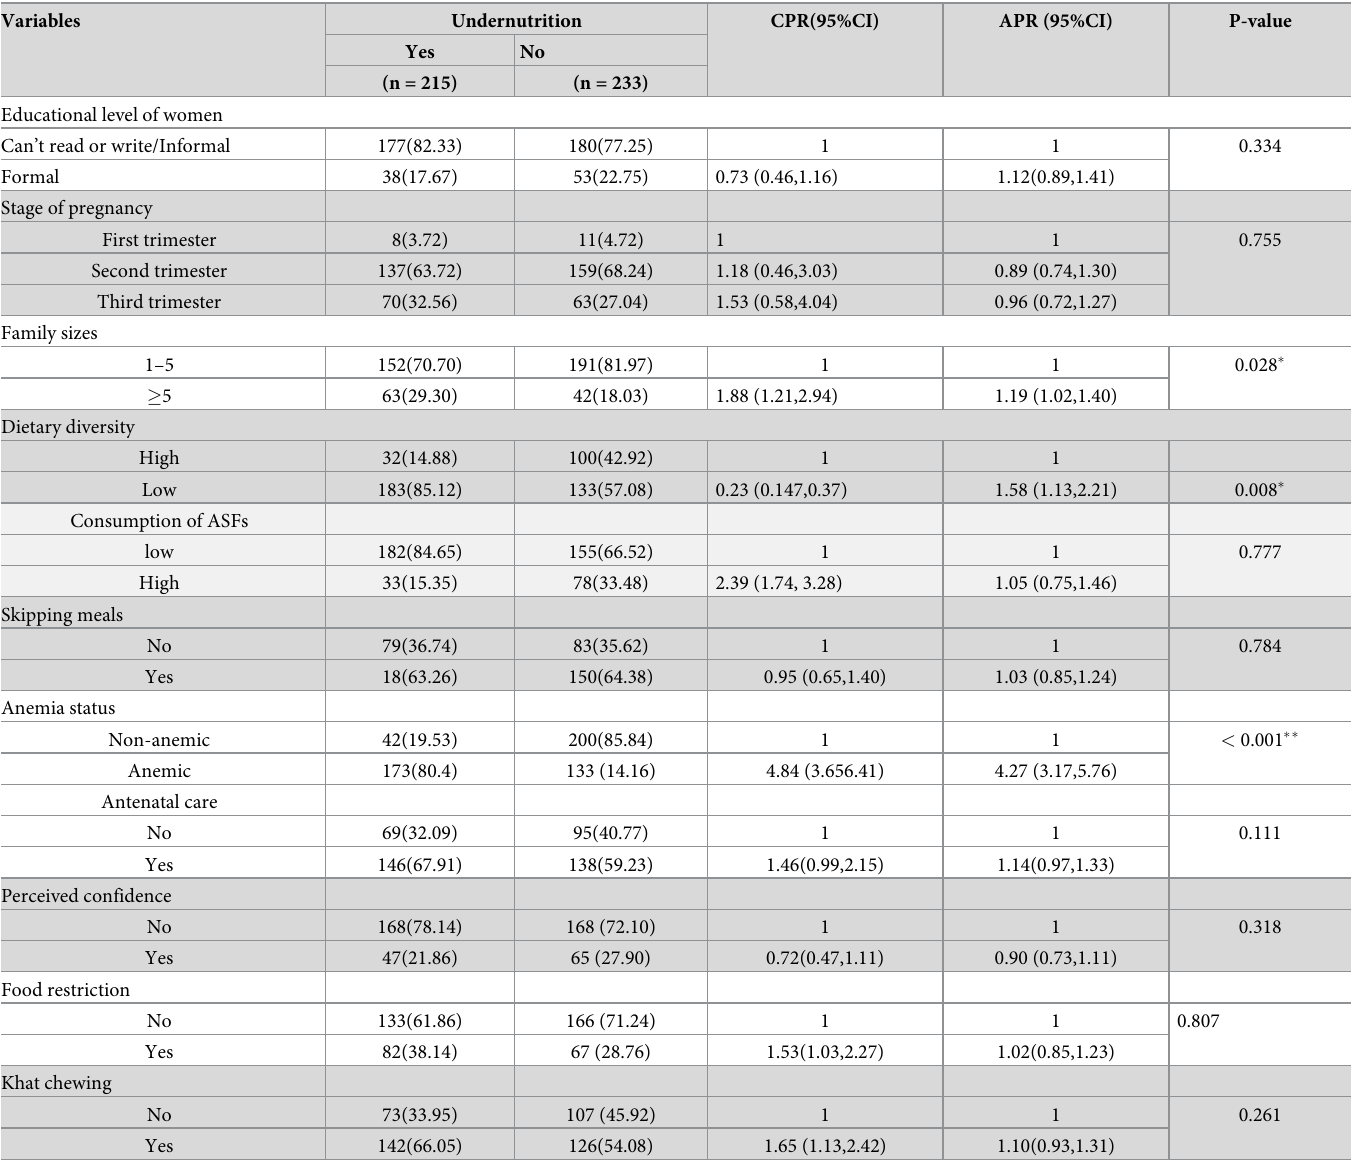
Table 3. Factors associated with undernutrition among pregnant women in Eastern Ethiopia,